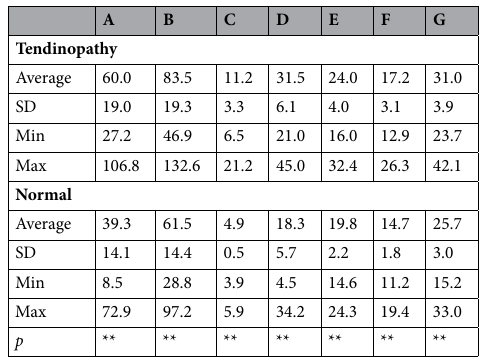
Table 2. Dimensions of the Achilles tendon in the experimental and control groups. A, B, C, D, F, G- dimensions of the Achilles tendon; definitions in the Material and Methods. SD—standard deviation, min.— minimum, max.—maximum. p < .001 marked as